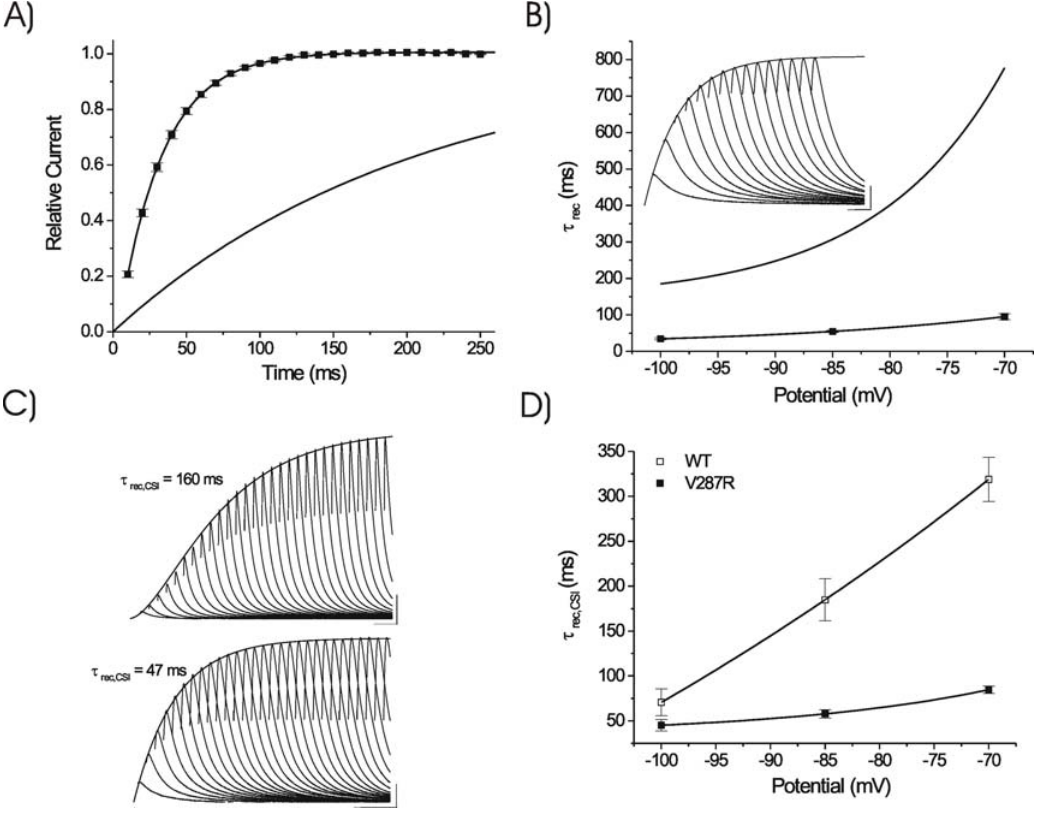
Figure 3. Recovery Characteristics. A) WT and V287R macroscopic recovery kinetics (HP= 2 100 mV) developed during a one second pulse to + 50 mV. Mean mutant data points (n=7) fit as a single exponential function with t rec =30.10 ms. WT t rec =206 ms, data from [9]. B) Main Panel : Comparison of the voltage dependence of mean t rec values of V287R and WT, from [9,10,16,25]. At all HPs, macroscopic recovery kinetics were significantly faster for V287R than for WT. Curve fits : WT: t rec =23.89e mV/11.14 + 142.10 ms, V287R: t rec =9.42e mV/21.77 + 13.95 ms. Inset : Representative macroscopic recovery waveforms for V287R (P2 currents at + 50 mV). Peak data points fit with a single exponential relationship with time constant=32 ms. Calibration bar: 200 nA, 20 ms. C) Representative recordings of recovery (HP= 2 85 mV) from closed-state inactivation for WT ( upper panel , fit as an ‘‘a 2 ’’ formulation) and V287R ( lower panel , exponential fit). Calibration bars: WT: 1 m A, 50 ms, V287R: 500 nA, 50 ms. D) Voltage dependence of mean t rec,csi values for WT (hollow squares, n=5) and V287R (solid squares, n=7). Curve fits : WT: t rec,csi =248.50e mV/93.1 2 582.10 ms, V287R: t rec,csi =5.80e mV/19.77 + 34.10 ms.